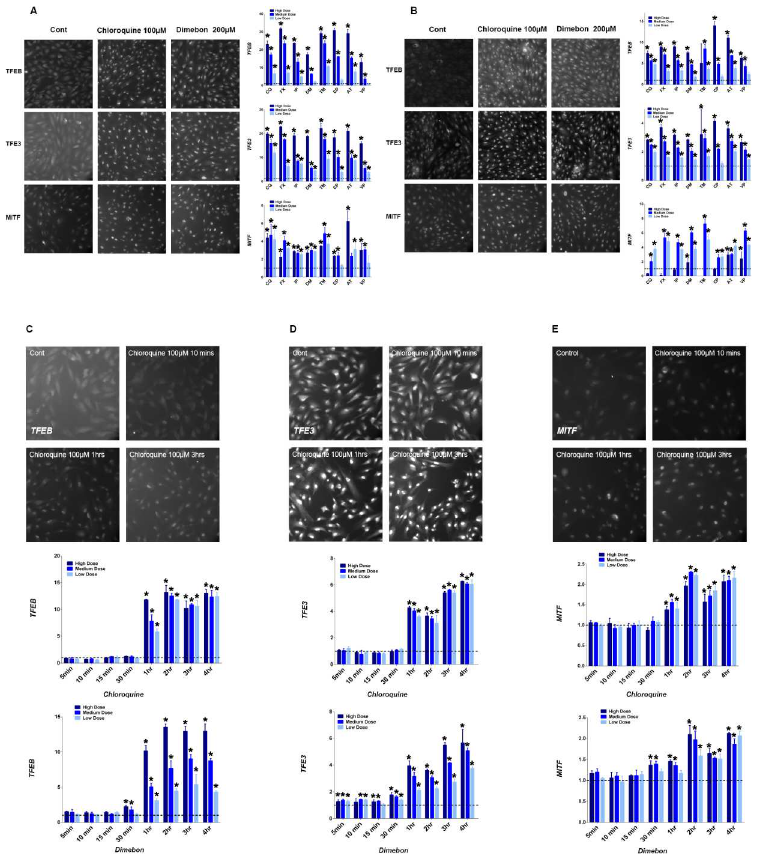
Fig 3. Increaseof nuclear translocation of TFEB, TFE3 and MITF. Representative imagesfor nuclear translocation of TFEB, TFE3 andMITF after 4 hrs (A) or 24 hrs (B) of drugtreatmentandfor the time course of the nucleartranslocation of TFEB (C), TFE3 (D) andMITF (E). Quantification data in eachpanelwaspresented as fold changeof total signalintensityinsidethe nucleuscompared to control(mean ± SD), * p (cid:20) 0.05. Tested drugsincludechloroquine (CQ), fluoxetine(FX), imipramine(IP), dimebon(DM), tamoxifen(TM), chloroproma- zine(CP), amitriptyline (AT), andverapamil (VP).